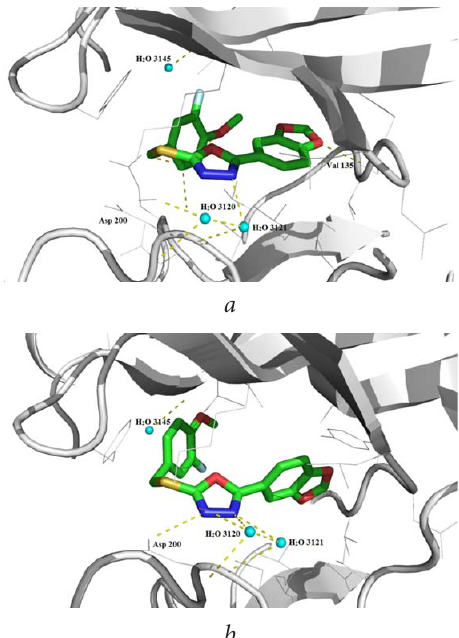
Fig. 2. Position of compound ( 1 ) in active site of GSK-3β : a – according to X-ray analysis data [10]; b –according to molecular docking